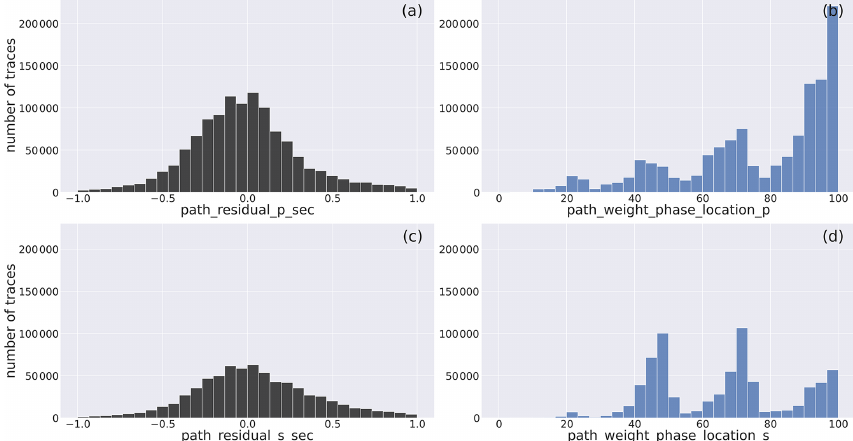
Figure 6. Histogram of the P- and S-wave residuals (a, c) and of the preassigned phase arrival weights, expressed as percent, resulting from the location (b, d) . The metadata names listed in Table 2 are used as labels for the specific metadata being represented.